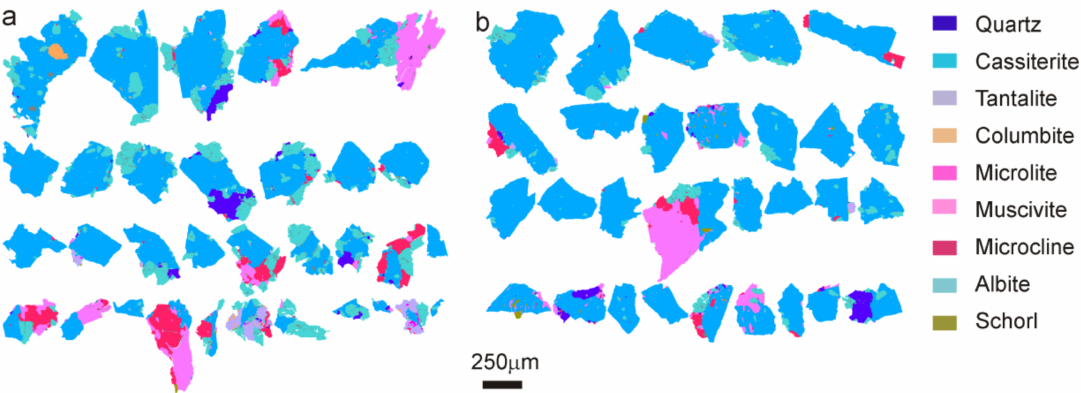
Figure 8. TIMA false color images for shape comparison of cassiterite-rich particles in the 250–600 size fraction obtained ( a ) with high-pressure grinding rolls (HPGR), and ( b ) BM. Color legend as in Figure